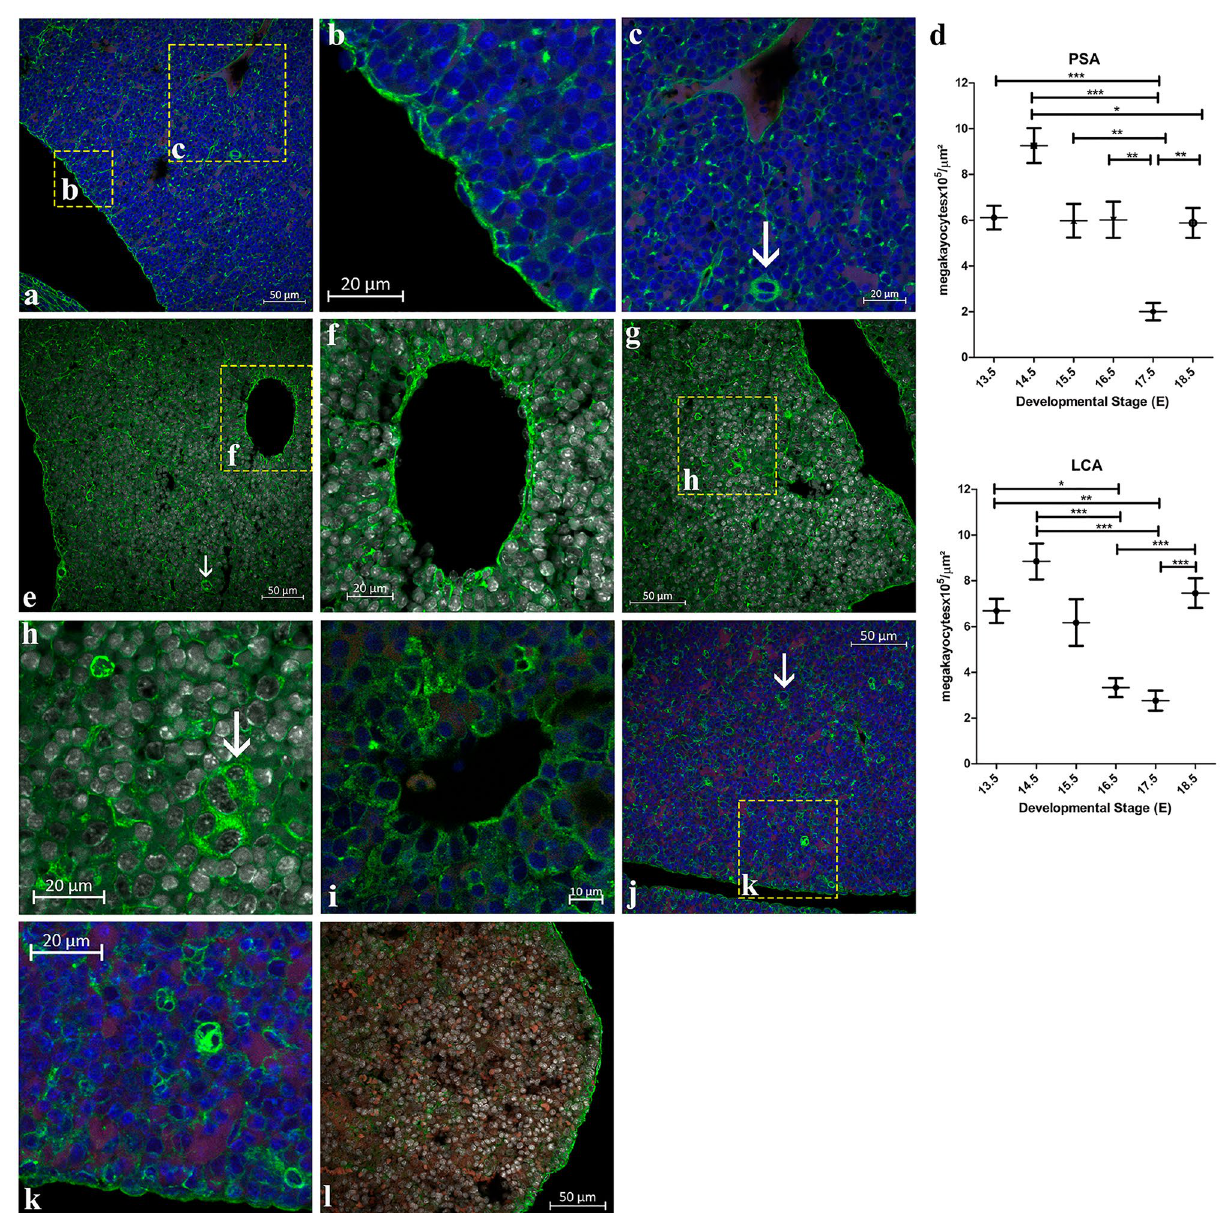
Figure 1. Mannose and glucose expression revealed by LCA ( a–c ), PSA ( e–h ) and CON A ( i–l ) lectins. An average of five fetal livers per slide from E13.5 ( i ), E15.5 ( a–c,j,k ), E16.5 ( e–h ) and E18.5 ( l ) were analyzed in two independent experiments and representative images are shown. Capsule and vessels intensely labeled, as well as megakaryocytes (arrow). D – graph with LCA and PSA in situ quantification of megakaryocytes. Results are presented as means and error bars denote ±SEM. At LCA experiment, an average of 21(16-30) fields were counted (mean-min-max) from E13.5 to 18.5. At PSA experiment, an average of 26 (16-46) fields were counted (mean-min-max) from E13.5 to 18.5. Green – AlexaFluor 488; white or blue (pseudocolors) – DAPI; red – galactose and lactose residues and is used to negatively select NK cells. Ricinus communis (RCA 120) is a per- ennial flowering plant known as castor bean or castor oil plant that binds to galactose, N-acetylgalactosamine and lactose residues. This lectin consists of two subunits of 60 kDa which can be dissociated by 27 and 33 kDa. Griffonia simplicifolia , (GSI/BSI) previously named as Bandeiraea simplicifolia , is a woody climbing shrub native of West Africa and Central Africa. The lectin extracted from this plant binds to galactose and N-Acetylgalactosa- mine residues. GSI is a lectin of 114 kDa composed by two types of subunits (A and B) that combines forming tetrameric structures, thus resulting in five isolectins. We tested six lectins described to recognize galactose residues in fetal livers from to E13.5 − 16.5, and five of them bound in the vessel walls of different diameters, liver capsules, and megakaryocytes of different sizes (Table 2). We extended the study from to E11.5 − 18.5 applying jacalin, the lectin that most effectively marked